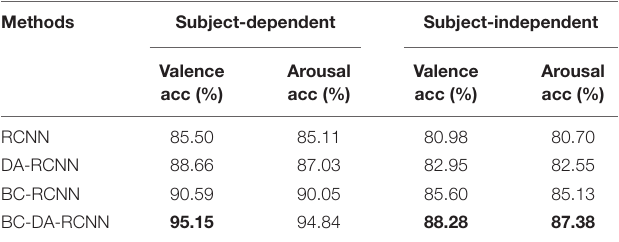
TABLE 7 | The experimental results of three variants of the proposed